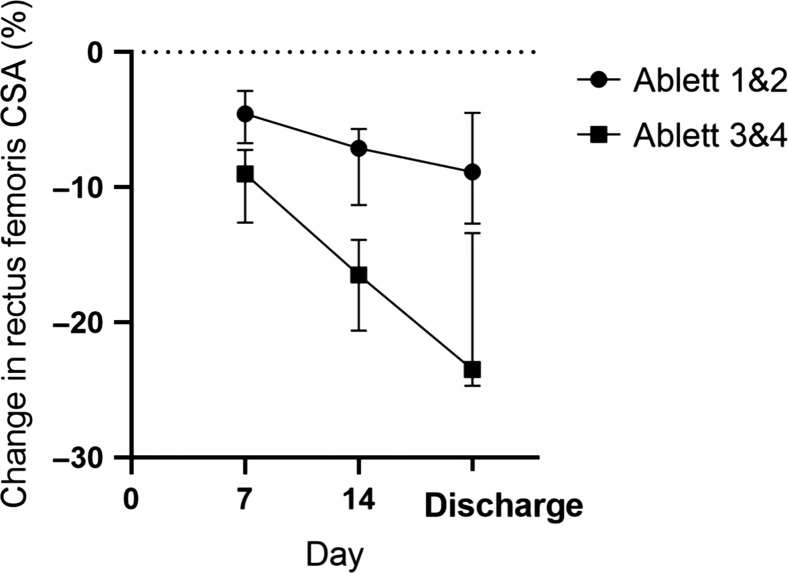
Median (95% confidence interval) change in RF-CSA (CSA) compared with baseline according to Ablett severity. Ablett grades 1 and 2: mild disease with spasms not interfering with respiration; Ablett grades 3 and 4: severe disease with spasms interfering with respiration with or without autonomic nervous system dysfunction.